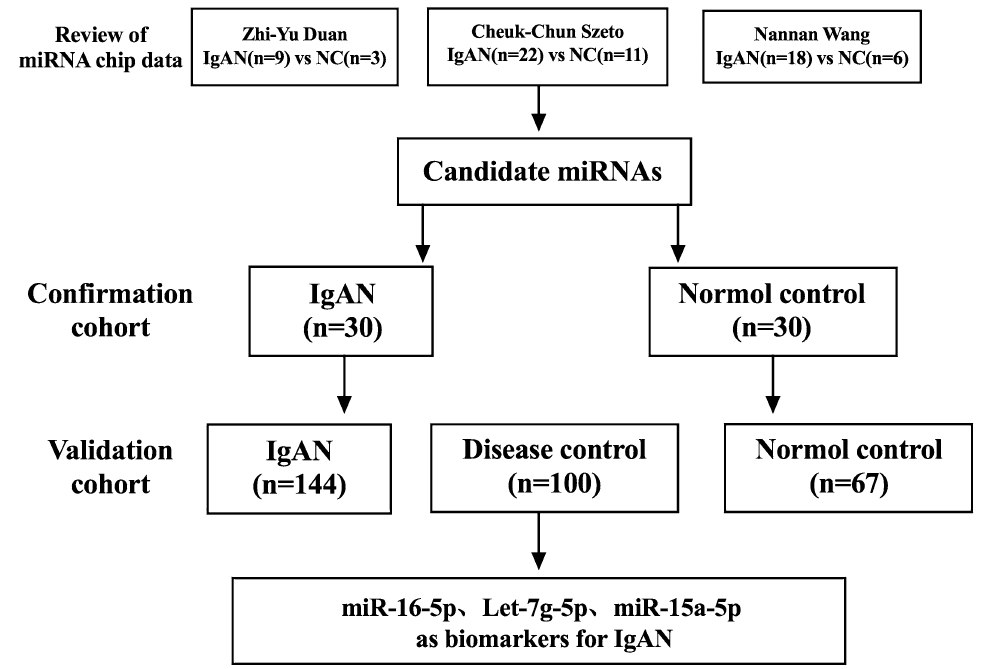
Figure 1. The discovery on IgAN